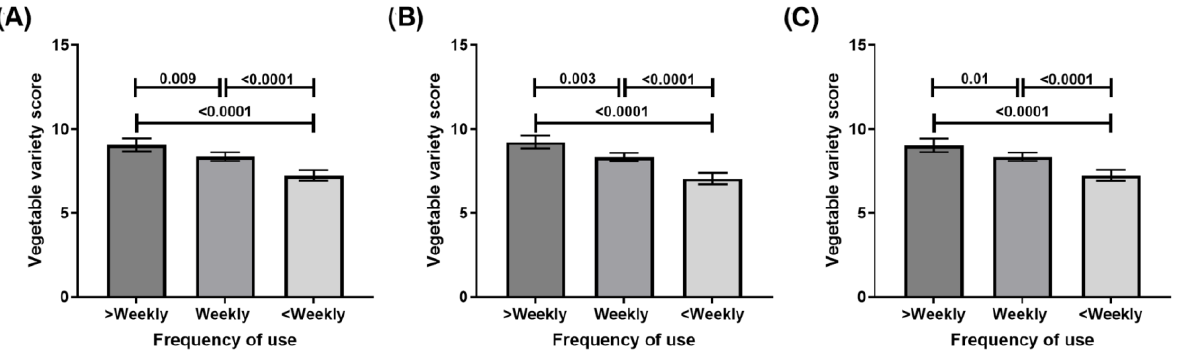
Figure 3. Vegetable variety scores by frequency of convenience cooking product use: ( A ) meal and recipe bases; ( B ) simmer sauces; ( C ) pasta sauces.